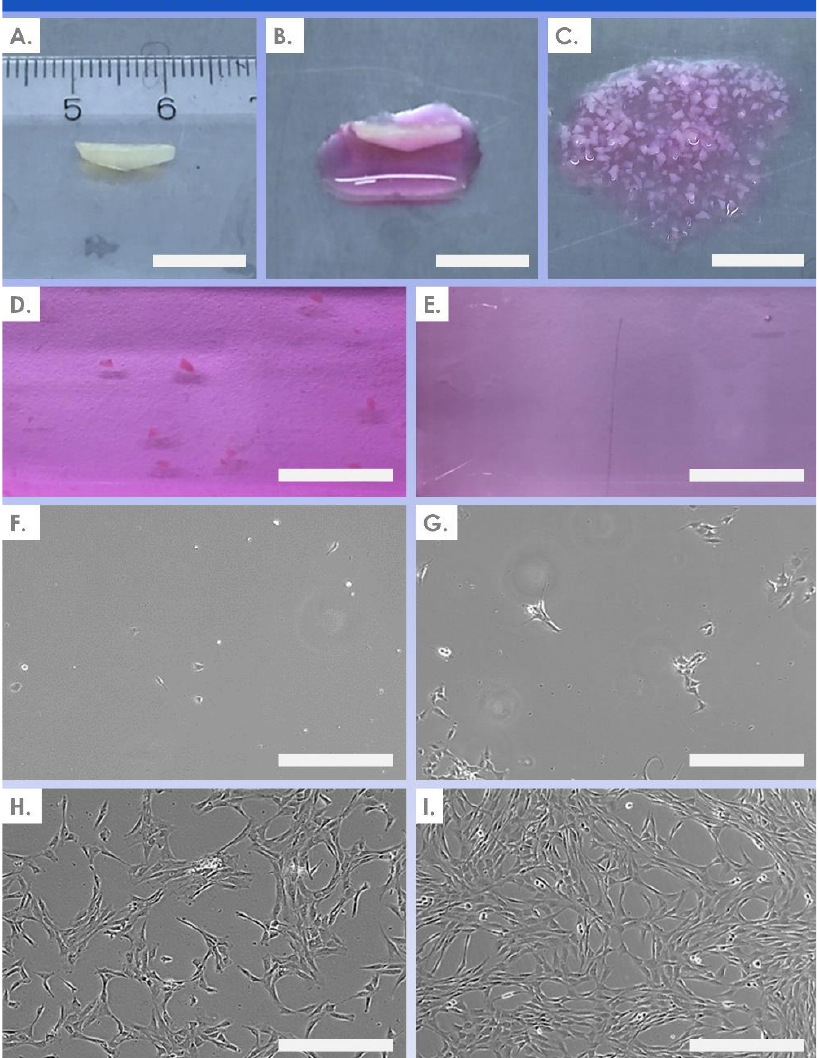
Figure 3. Photographic illustrative overview of the sequential mechanical and two-step enzymatic cartilage biopsy processing phases, followed by in vitro monolayer HAC expansion. ( A ) Procurement of the healthy cartilage tissue biopsy (i.e., size of 4 mm × 10 mm). Scale bar = 1 cm. ( B ) Humidification of the cartilage tissue biopsy for further processing. Scale bar = 1 cm. ( C ) Manual fragmentation of the cartilage tissue biopsy into < 1 mm 3 fragments. Scale bar = 1 cm. ( D ) Two-step digestion of the cartilage tissue biopsy fragments with pronase and with collagenase. Scale bar = 1 cm. ( E ) Verification of complete cartilage tissue biopsy fragment digestion after overnight incubation with the lytic enzymes. Scale bar = 1 cm. ( F – I ) Photographic illustrative overview of sequential monitoring timepoints during the in vitro monolayer HAC culture expansion (i.e., cells at passage level 2, with photographs taken after 24 h, 2 days, 4 days, and 7 days of culture, respectively). Scale bars = 150 µm. h, hours; HAC, human articular chondrocytes.